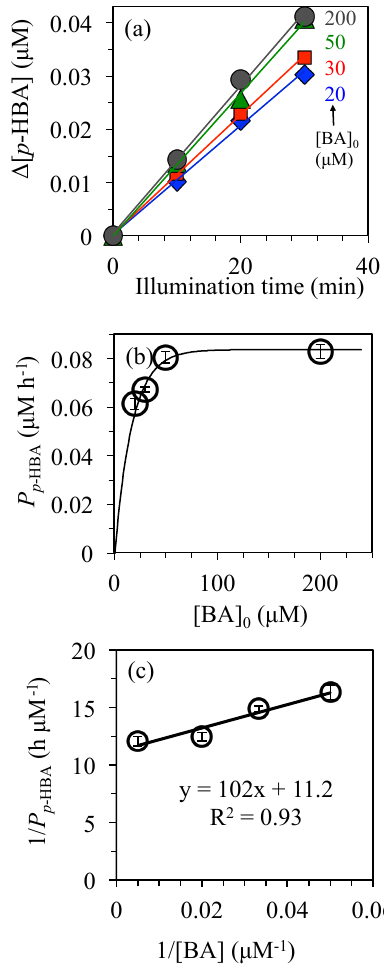
Figure 2. Example of kinetic results for Summit sample 0526 stud- ied in the laboratory. Panel (a) shows the increase in p -HBA con- centration during illumination in four aliquots of the sample con- taining different initial BA concentrations ([BA] 0 ) illuminated for 30min with simulated sunlight. The diamonds (blue), squares (red), triangles (green), and circles (gray) correspond to BA concentra- tions of 20, 30, 50, and 200µM, respectively. The lines represent linear regression fits to data at each BA concentration (with y inter- cept fixed at zero). Panel (b) shows the measured production rate of p -HBA for each BA concentration and the accompanying regres- sion fit. Error bars represent ± 1 standard error based on the linear regression slopes in panel (a) . Panel (c) is the “inverse” plot and lin- ear regression fit, whose slope and y intercept are used to calculate P OH , k (cid:48) OH , and [ • OH] (see Sect. 2.7 for more details). Error bars based on ± 1 standard error calculated in panel (b)